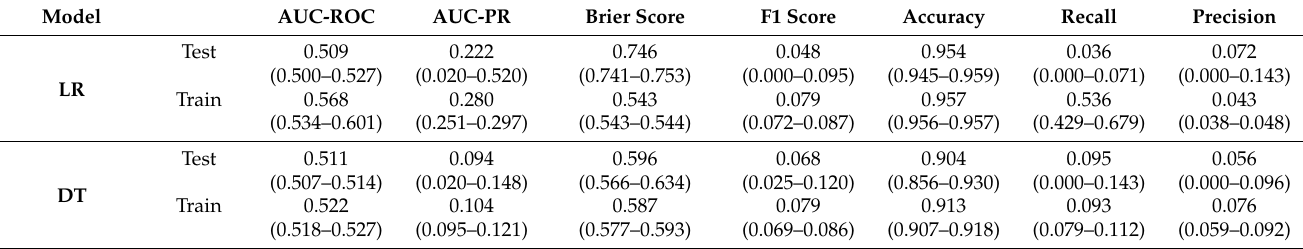
Table 2. Base classifiers